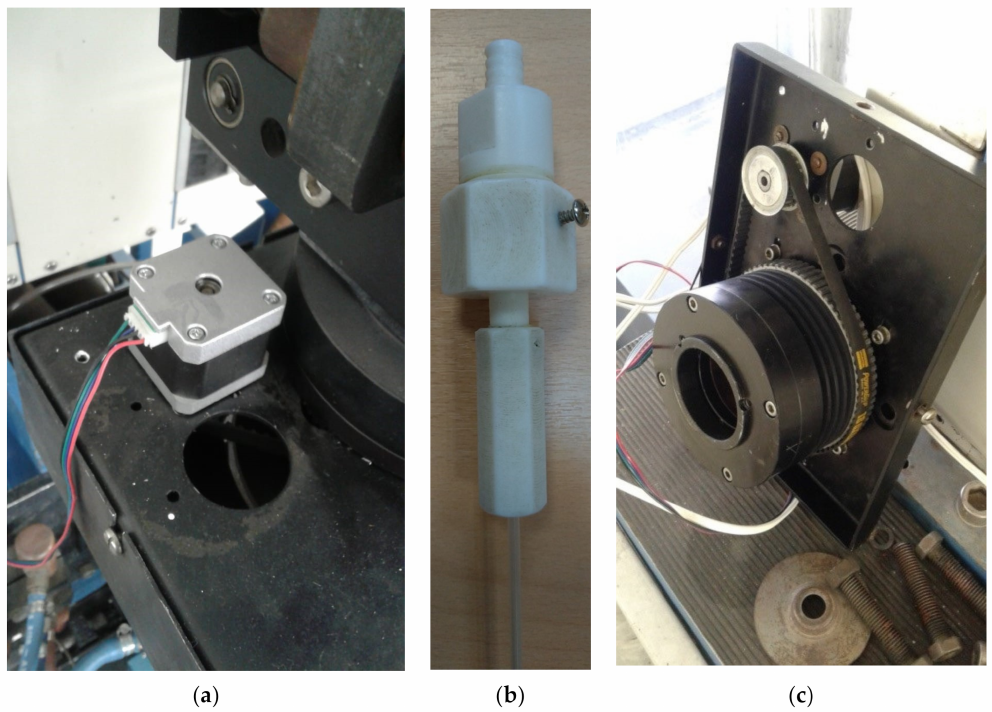
Figure 1. Previously performed modifications to the drawing tower feed unit: ( a ) top of the feed unit with installed stepper motor that rotates a preform under desired speed; ( b ) completed and jointed fluoroplastic rotational adapter with installed MOF cane; ( c ) removed supporting pad with stepper motor and its driving